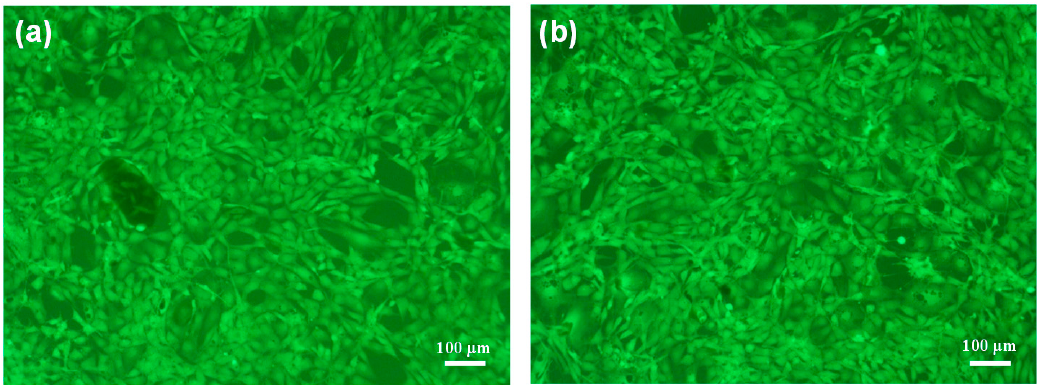
Figure 6. Fluorescence microscopy images of NIH/3T3 cells grown on the PDOPA- g -PLA 5 ( a ) and PDOPA- b -PLA 5 ( b ) copolymers.